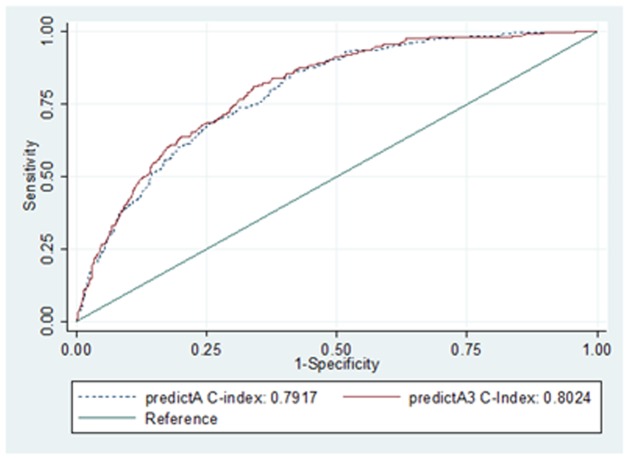
Area under the ROC curve for the models with/without interactions.Footnote toFigure 5: predictA: model without interactions predictA3: model with 3 interactions.